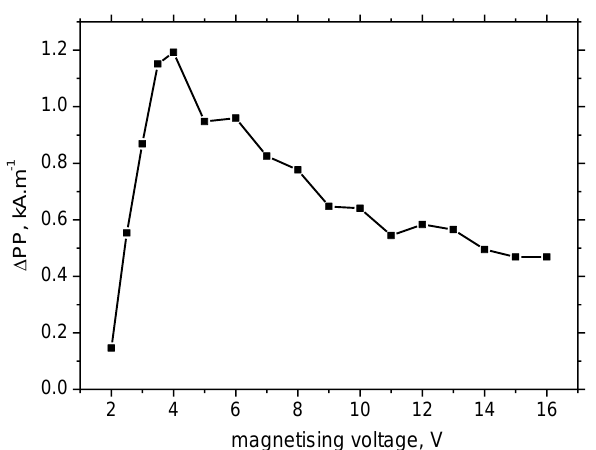
Figure 15. Difference in PP between the positive and negative bursts as a function of magnetising voltage.